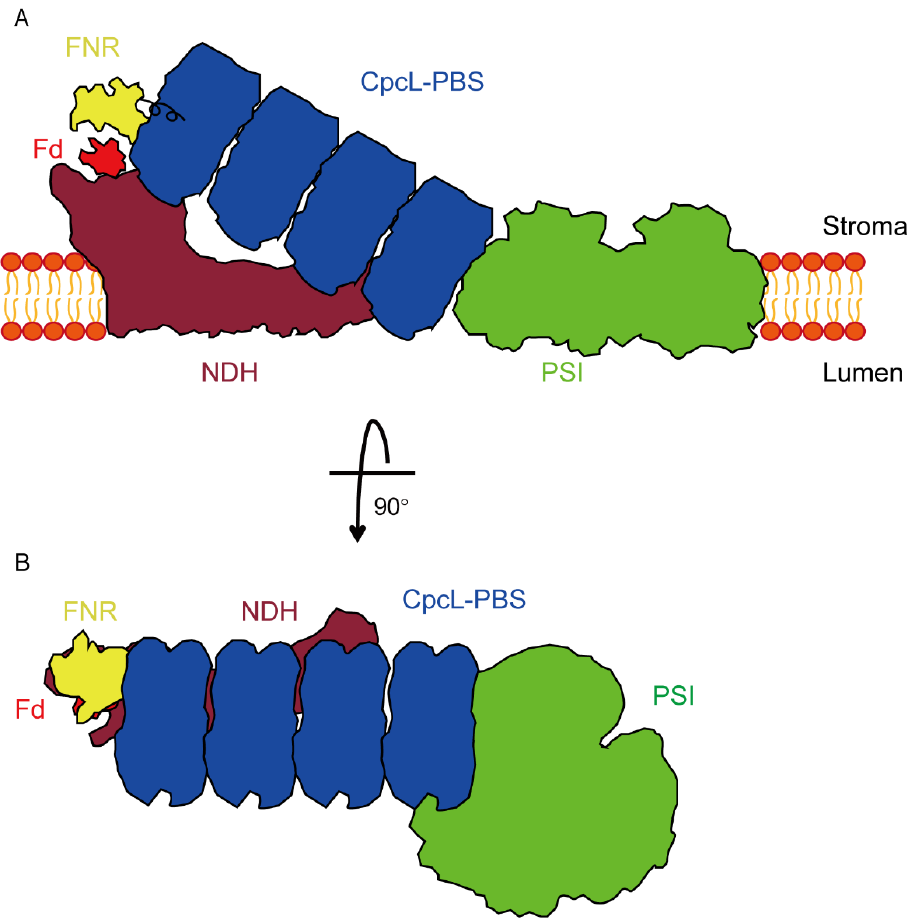
Figure 8. Schematic model of NADPH-dehydrogenase complex (NDH)-CpcL-PBS-PSI trimer super- complex from sideview ( A ) and top-view ( B ). CpcL-PBS-PSI trimer complex interacts with NDH to form supercomplex. In the supercomplex, the FNR attached to CpcL-PBS could efficiently transfer electrons from NADPH to Fd that is in turn oxidized by NDH located on thylakoid membranes under photoheterotrophic growth conditions. The model is drawn in proportion according to the actual sizes of the supercomplex components.